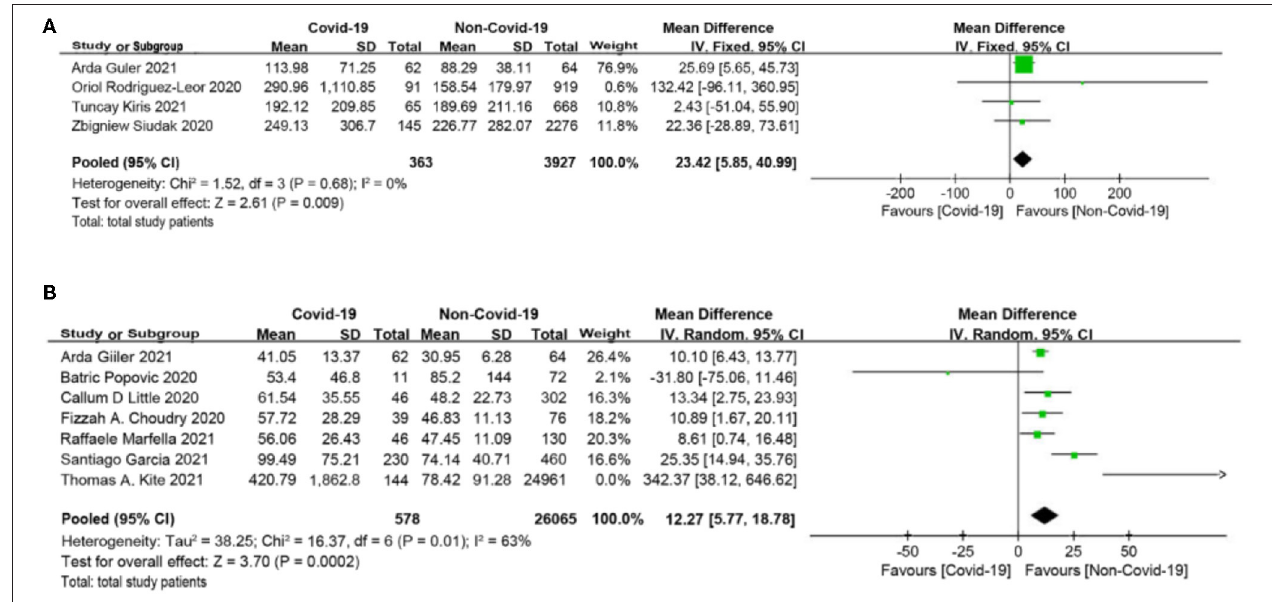
FIGURE 2 | (A) Symptom onset to first medical contact (SO-to-FMC) time forest plot (minutes). (B) Door to balloon (D2B) time forest plot